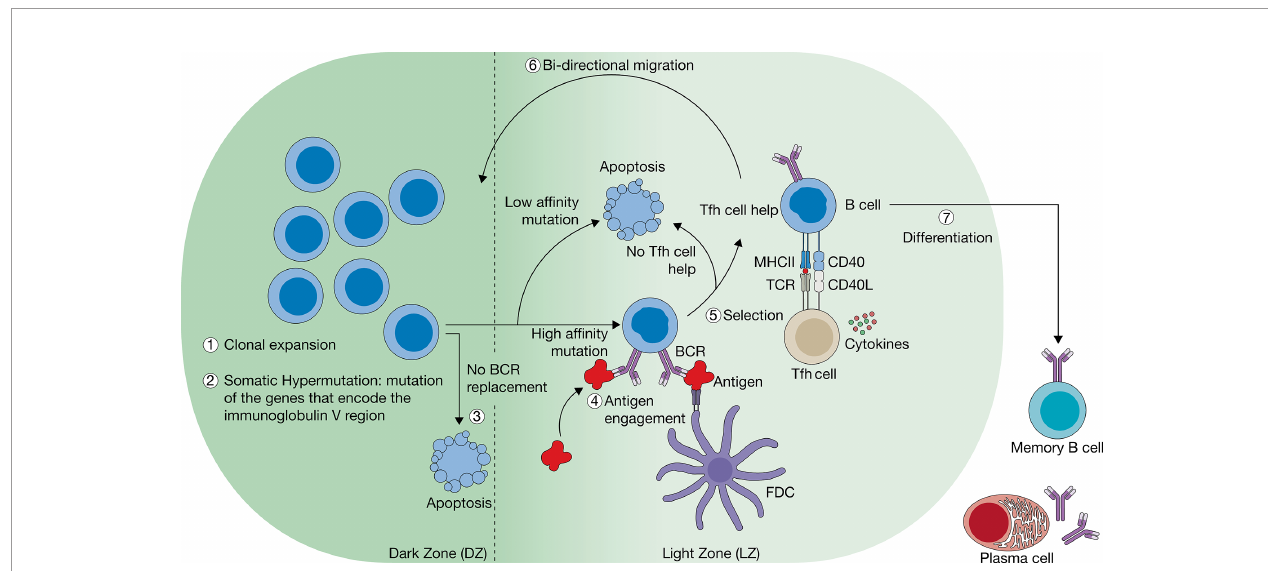
FIGURE 2 | The germinal center (GC) reactions. In the dark zone (DZ) of the GC, B cells undergo clonal expansion (1), which is accompanied by spontaneous point mutations in the gene that encodes for the variable domain of the B cell receptor (BCR) (2). GC B cells (GCBCs) with mutations that compromise BCR expression are removed through apoptosis (3). GCBCs with functional BCRs test the potentially altered af fi nity in the GC LZ through interactions with the antigen (4) and Tfh cells, which provide CD40L and cytokines (5). GCBCs that obtained a higher af fi nity BCR are expected to outcompete those with weaker af fi nity as a result of these interactions (4 and 5). Ultimately, positively selected B cells are the only ones to survive and either re-circulate to the DZ (6) or differentiate into either memory B cells (MBCs) or plasma cells (PCs)